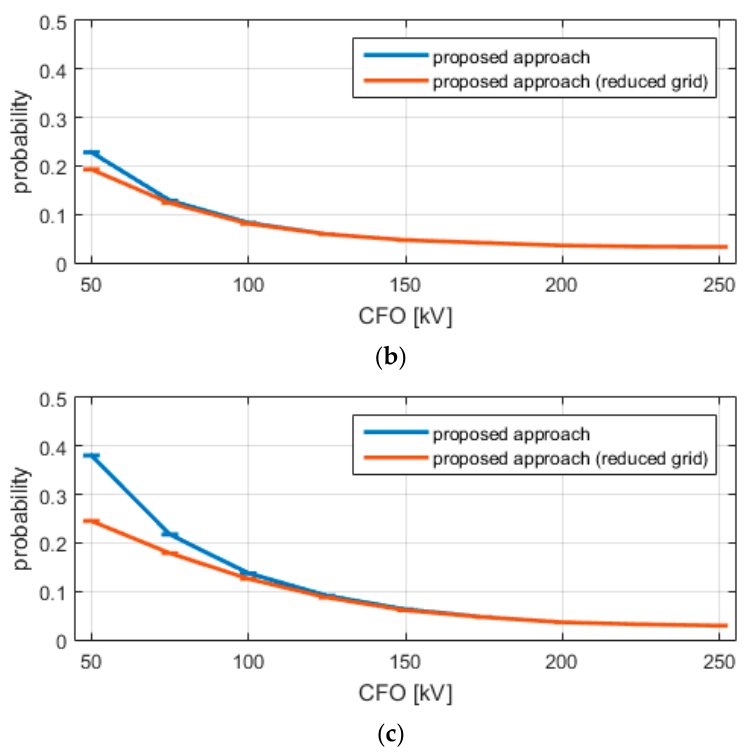
Figure 6. Comparison of the proposed approach performed on the original domain (blue) and on the reduced one (red). Panels ( a – c ) show the results for Test1, Test2, and Test3, respectively.